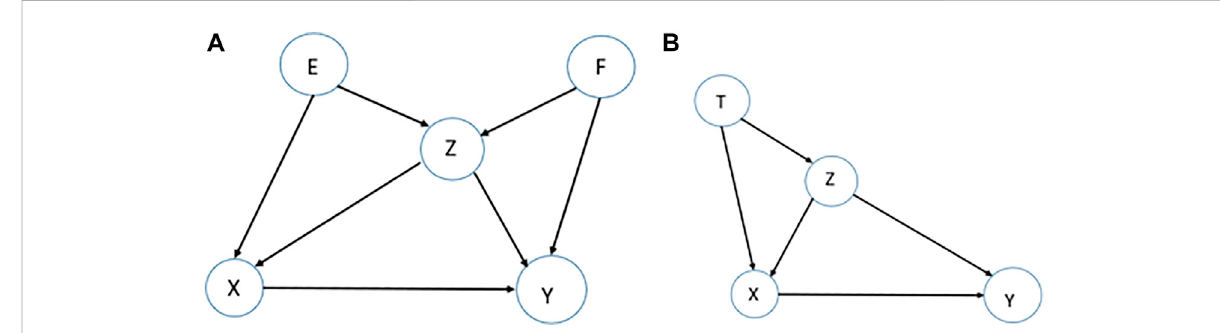
FIGURE 4 Examples for stability tests. (A). To assess the effect of { X } on { Y } in this causal network, there are two equivalent sets of confounders { E , Z } and { F , Z }, which means considering either of the sets, the study of the effect { X } on { Y } is unconfounded and the effect does not vary signi fi cantly (Confounding-equivalent Test). (B). To assess the effect of { X } on { Y } in this causal network, { Z } is the confounder. Therefore, knowing the value of variable T does not change estimating the effect of { X } on { Y } if we hold the variable { Z }